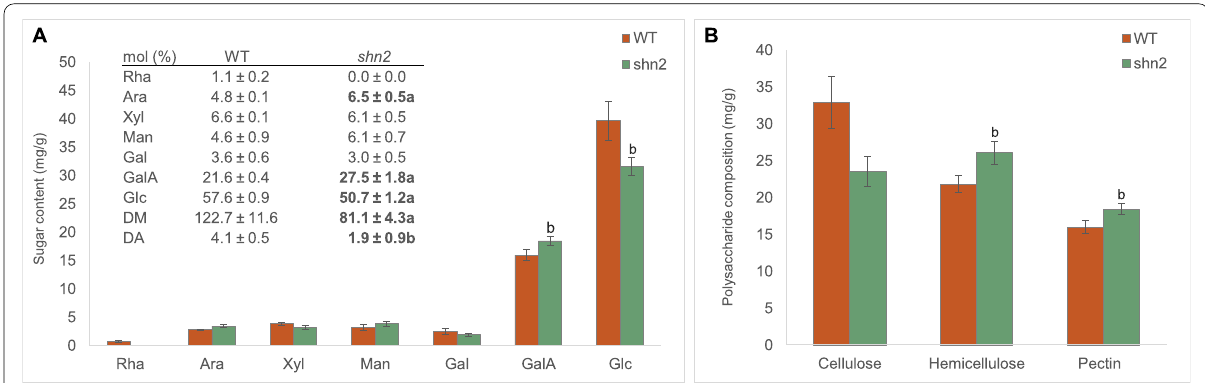
Fig. 5 Cuticle-embedded polysaccharides are altered in the shn2 mutant. A Sugar content; the inset table represents the sugar composition expressed as total sugar mole percentage. The degree of methyl esterification (DM) refers to the molar amount of methanol per 100 mol of galacturonic acid while the degree of acetylation (DA) is reported as the weight of acetic acid/weight of polysaccharides. Values are mean ( n 3). Values in bold indicate significant difference from the WT. a, P < 0.01; b, P < 0.05 (Student’s t test). Rha, rhamnose; Ara, arabinose; Xyl, xylose; = Man, mannose; Gal, galactose; GalA, galacturonic acid; Glc, glucose. B Polysaccharide composition. Cellulose: glucose deduced from second hydrolysis; hemicellulose: total neutral sugar with glucose from second hydrolysis only; pectin: galacturonic acid. Values are mean